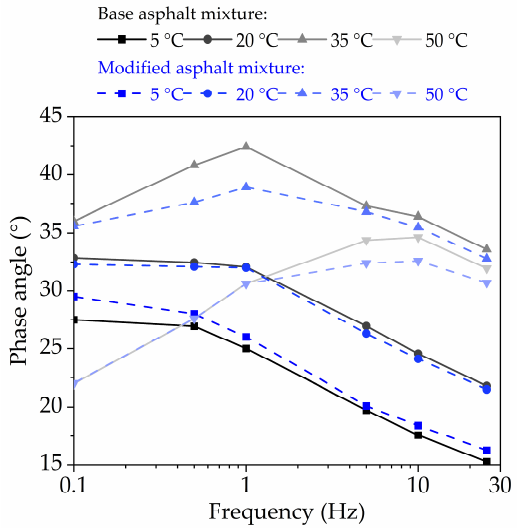
Figure 12. The phase angle of base bituminous mixture and nano-TiO 2 /CaCO 3 modified bituminous mixture at different test temperatures.